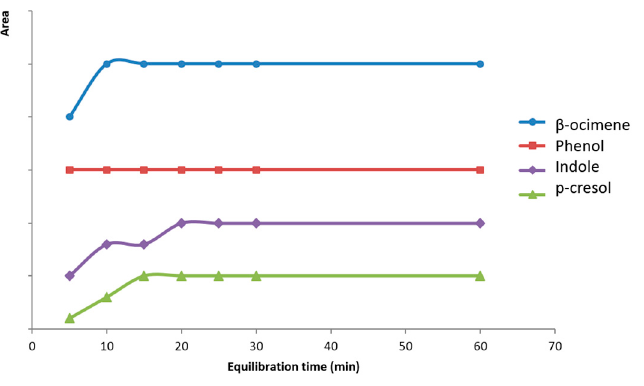
Figure 6. Variation of chromatographic peak area with equilibration time for each volatile compound.